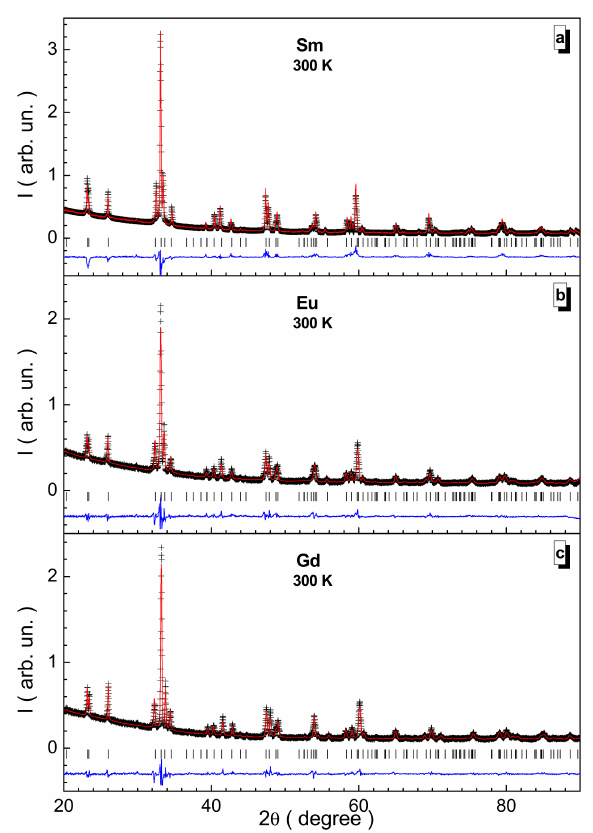
Figure 1. Rietveld-refined XRD pattern for the Sm- ( a ), Eu- ( b ), and Gd-based ( c ) samples. The experimental data (cross), fitting curve (red line), theoretical Bragg positions (vertical bar), and difference curve (blue line) are